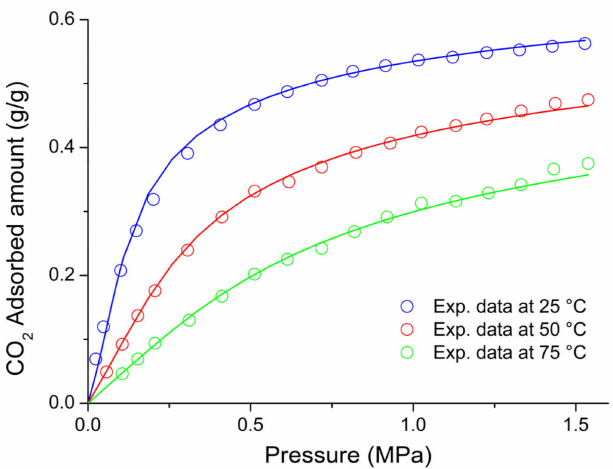
Figure 5. Comparison between experimental CO 2 adsorption data in Cu-BTC [48] and simultaneous optimized RALF model fitting (solid lines).